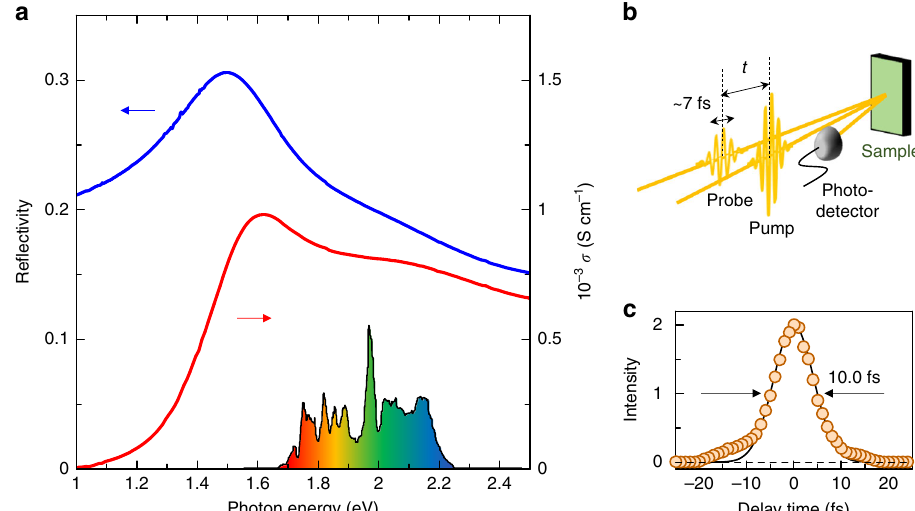
Fig. 2 Optical spectra and pump-probe re fl ection setup on CuO 2 planes in Nd 2 CuO 4 . a The re fl ectivity ( R , blue) and optical conductivity ( σ , red) spectra measured on the ab plane. Electric fi elds of lights are polarized parallel to a or b axis. The black line in the lower part shows a spectrum of a 7-fs pulse used in the pump-probe (PP) experiments. b A schematic of PP experiments. c A cross-correlation pro fi le of pump and probe pulses corresponding to the time